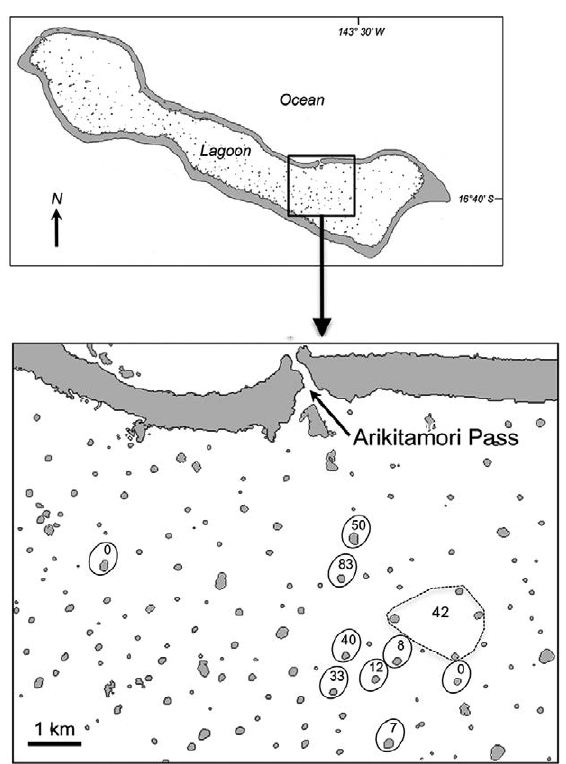
Fig. 1. – Location of the experimental site in the northeastern part of Makemo Atoll (Tuamotu Archipelago, French Polynesia). The dashed line encompasses the four reef pinnacles sampled during the first field campaign (November-December 2011). Full circles indicate the nine other reef pinnacles sampled during the second field campaign (October-November 2013). Numbers refer to the occupation rates (i.e. percentage of the collected bivalves Pinctada margaritifera being occupied by carapid fish Onuxodon fowleri ) observed on the reef pinnacles. A detailed listing of the collected samples is given in Table 1.